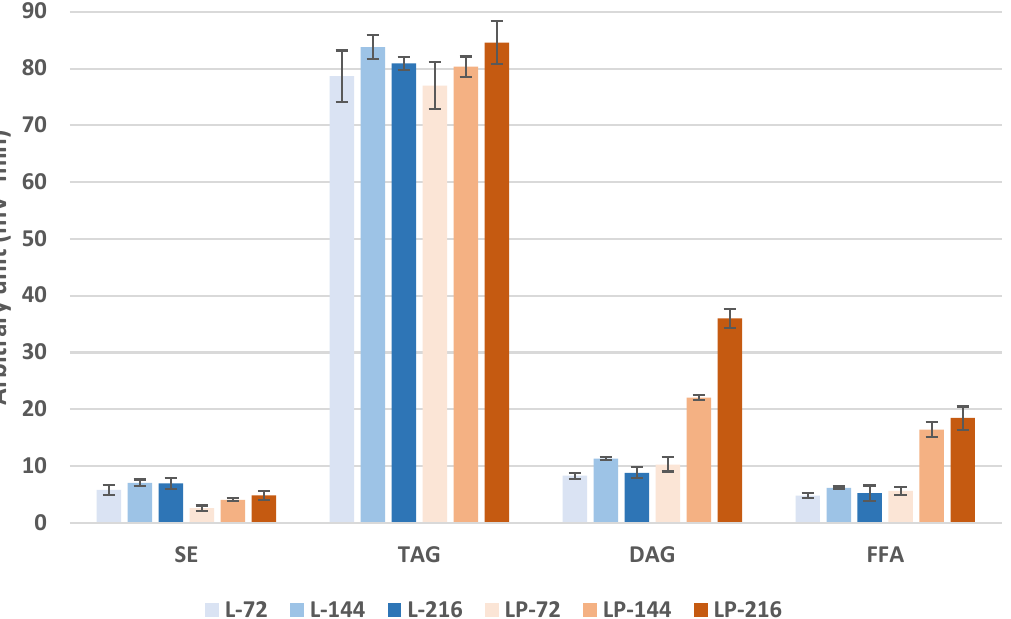
Figure 4. Comparison of the storage lipid content in the obese L and obese LP over time. SE—sterol esters; TAG—triacylglycerols; DAG—diacylglycerols; FFA—free fatty acids. Mean values are displayed ( n = 3, ± SD).